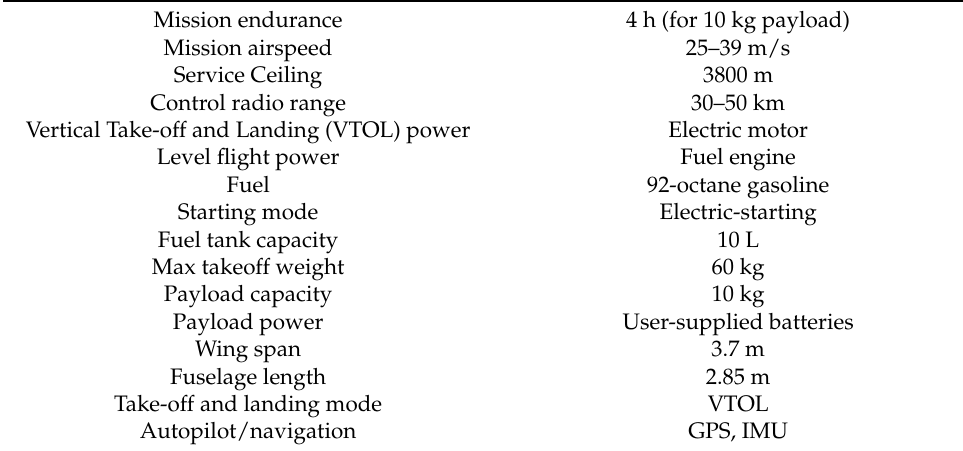
Figure 1. The developed unmanned aerial vehicle (UAV)-based flux measurement system with the coordinate system information ( a ) and the computer graphic of the carried scientific payloads ( b ). Table 1. Specification and performance of the